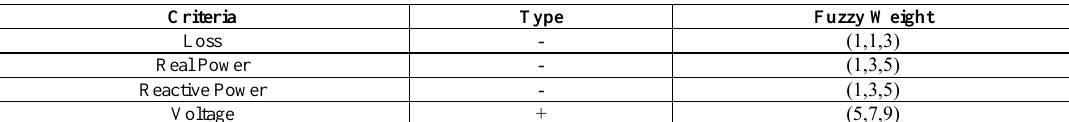
Table 7. Characteristics of criteria.